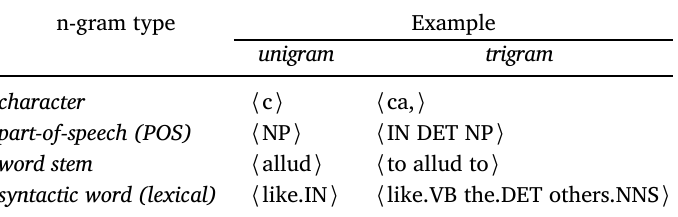
Table 3: Feature